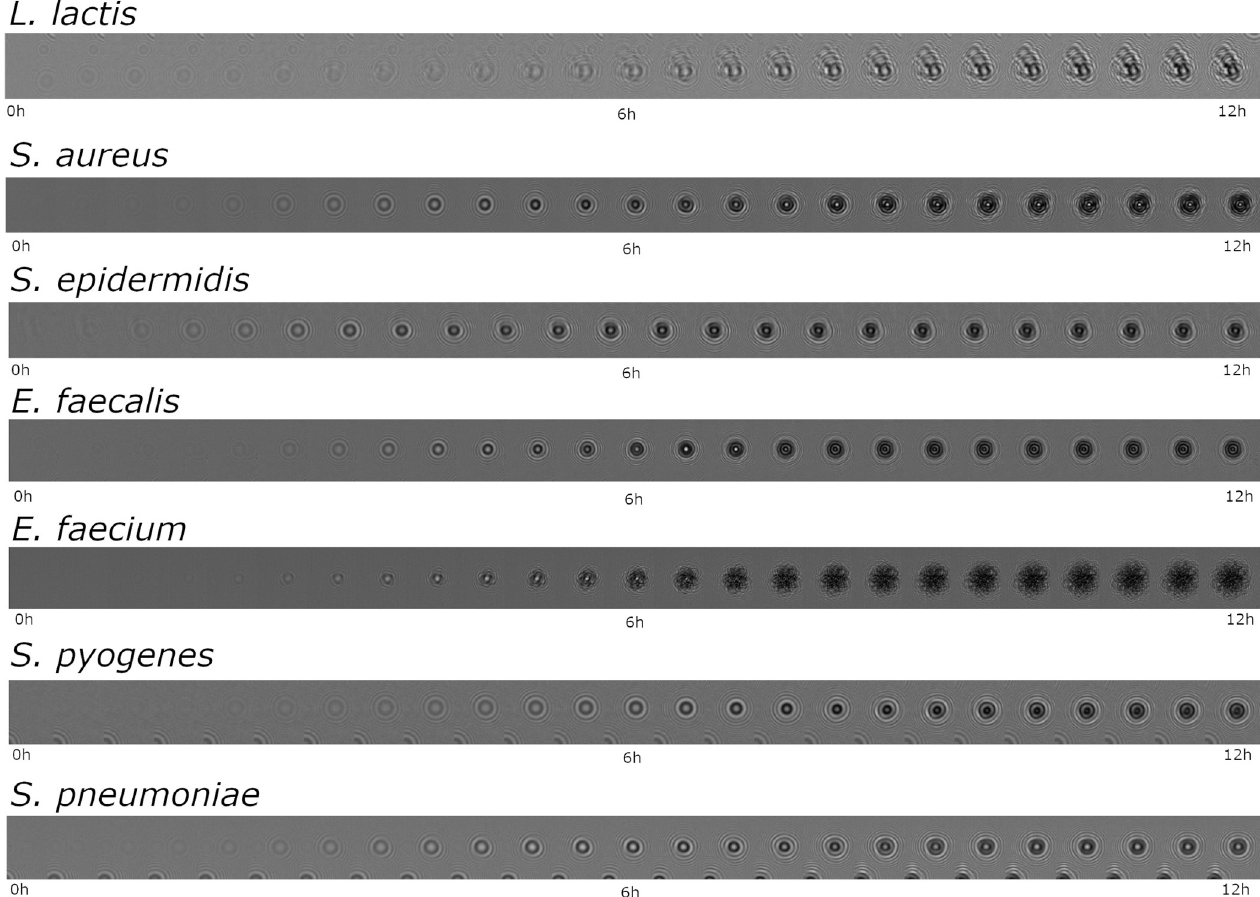
Fig 5. Growth kinetics. Growth kinetics of L . lactis , S . aureus , S . epidermidis , E . faecalis , E . faecium , S . pneumoniae and S . pyogenes over a twelve-hour incubation time with a 30-minute period between each frame. Each frame is a 64x64-pixel image (107x107 μ m).